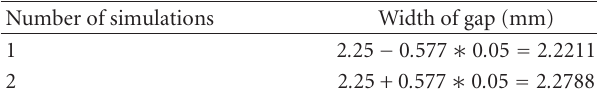
Table 2: Points of sigma approach to one